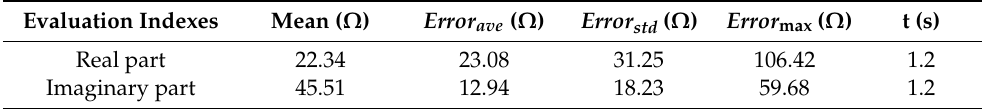
Figure 20. Results of method 4 in 3rd harmonic. ( a ) Result of real part; ( b ) Result of imaginary part. Table 7. Evaluation indexes of method 4 in 3rd Table 7. Evaluation indexes of method 4 in 3rd harmonic.